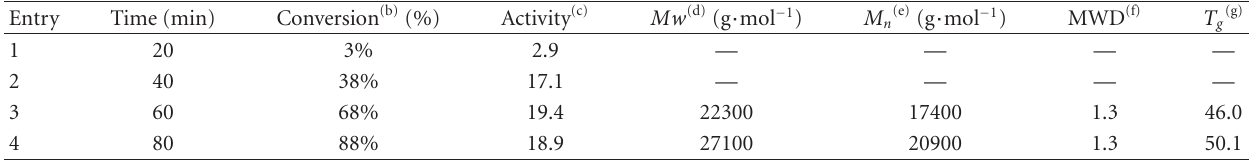
Table 2: Microwave- assisted polymerisation of L,D -LA using complex ( 1 ) (a) .